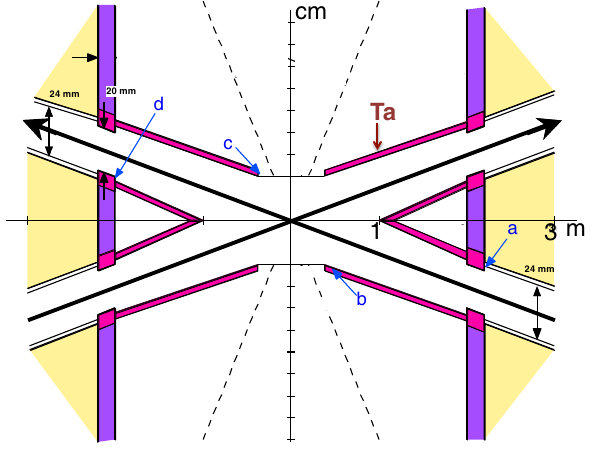
FIG. 7. Tantalum shielding is shown in red around the IR beam pipe from 0.5 m to 1.5 m from the